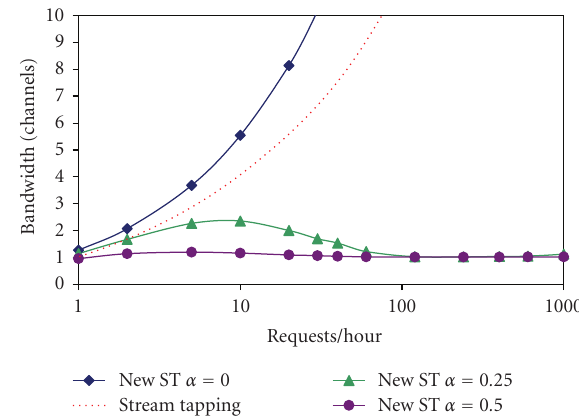
Figure 4: Server bandwidth requirements of the new stream tapping